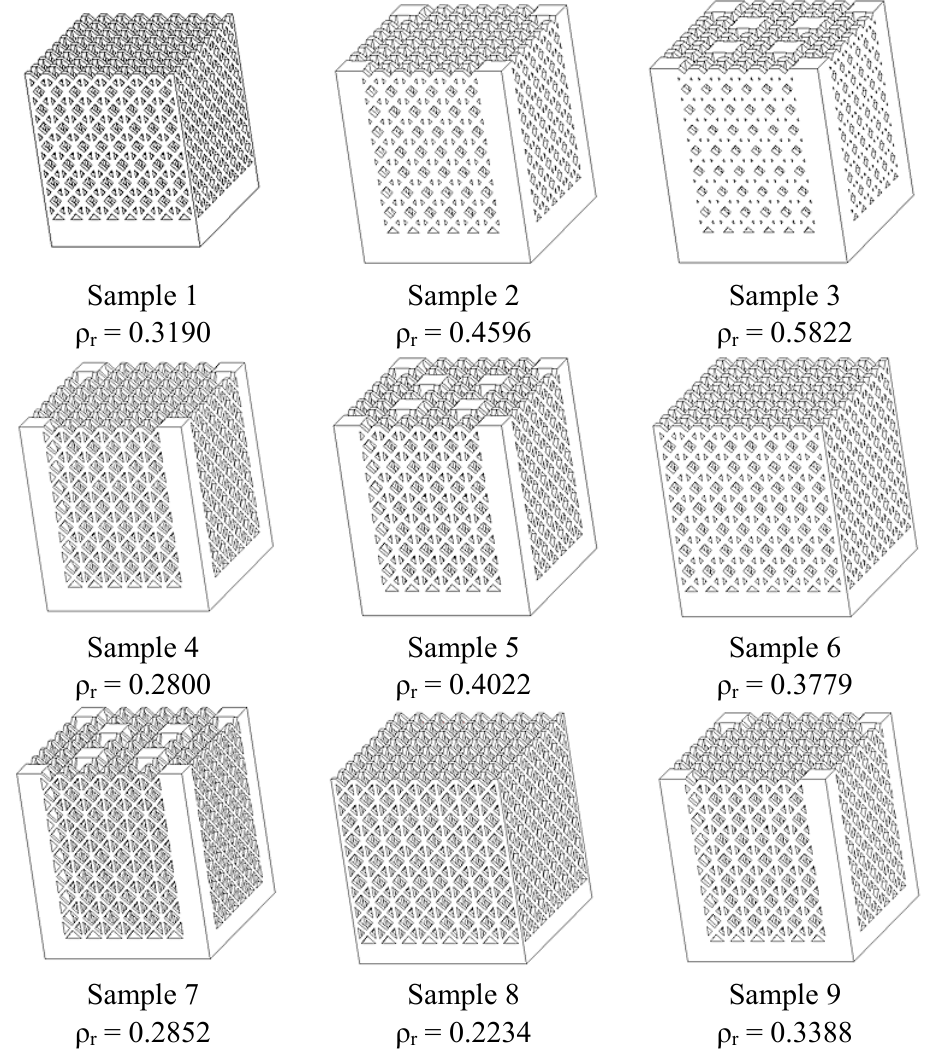
Figure 11. Cell topologies of the nine combinations of